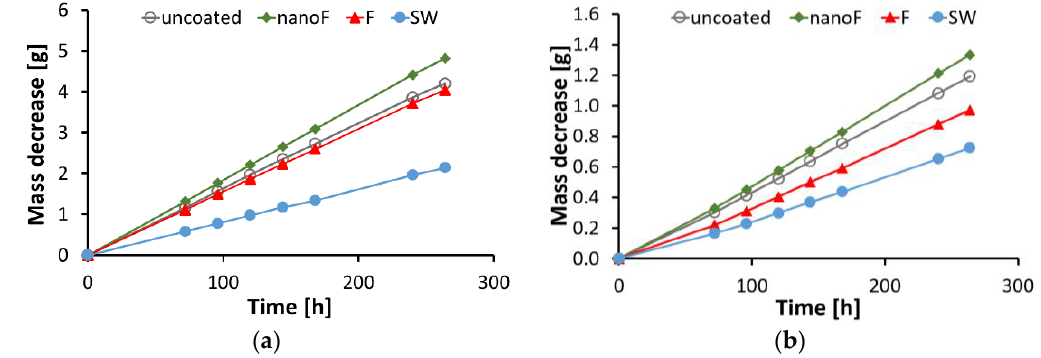
Figure 7. Variations of mass measured during the vapor transmission test for uncoated and coated ( a ) PS and ( b ) CS stone surfaces.